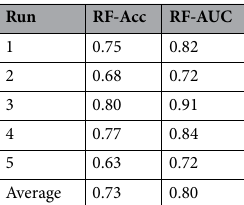
Table 3. Verified versus unverified COVID subject